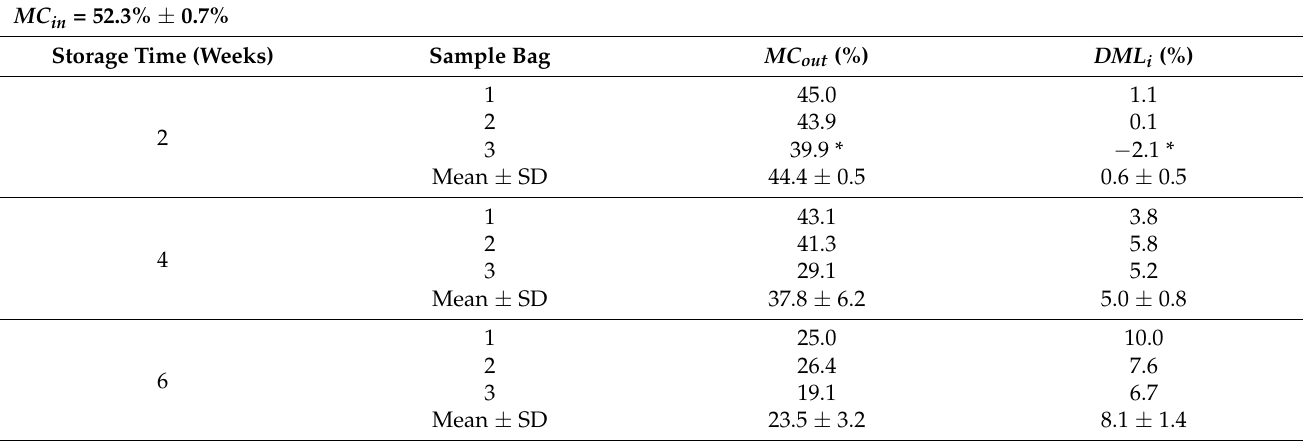
Table A2. Moisture content and dry matter losses of the sample bags in trial